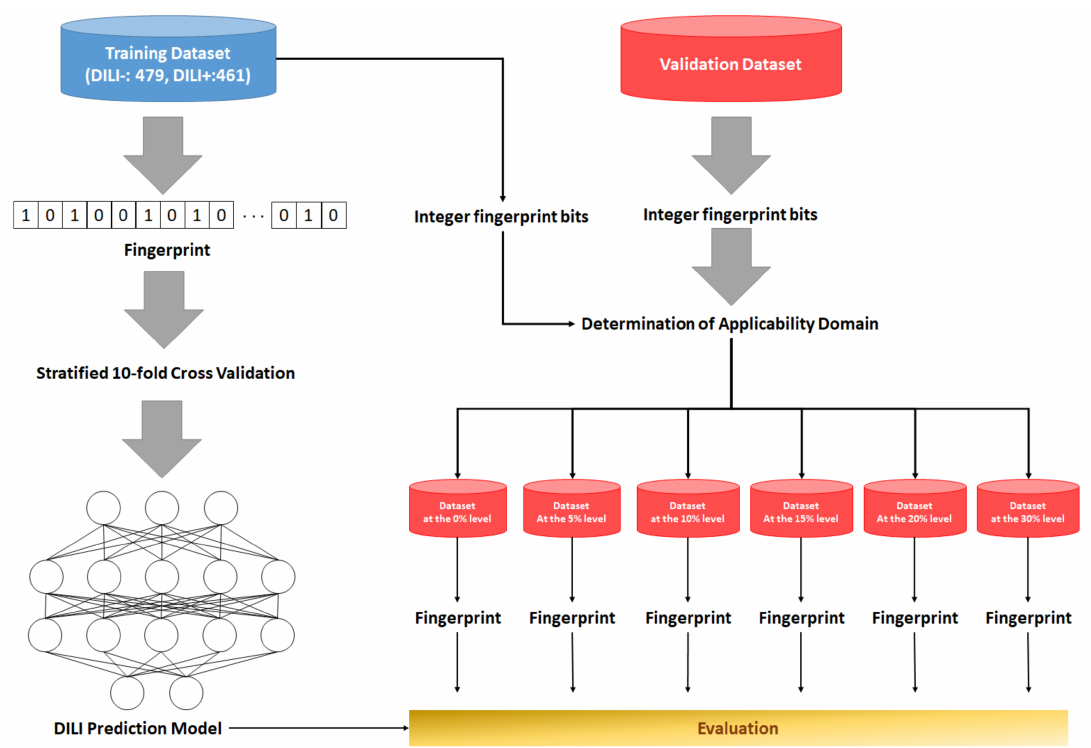
Figure 2. Overall workflow for model creation and evaluation. Models were created based on chemical structure-based fingerprints using various algorithms and subsets from validation data sets selected by the applicability domain, which was defined by the endurance level.